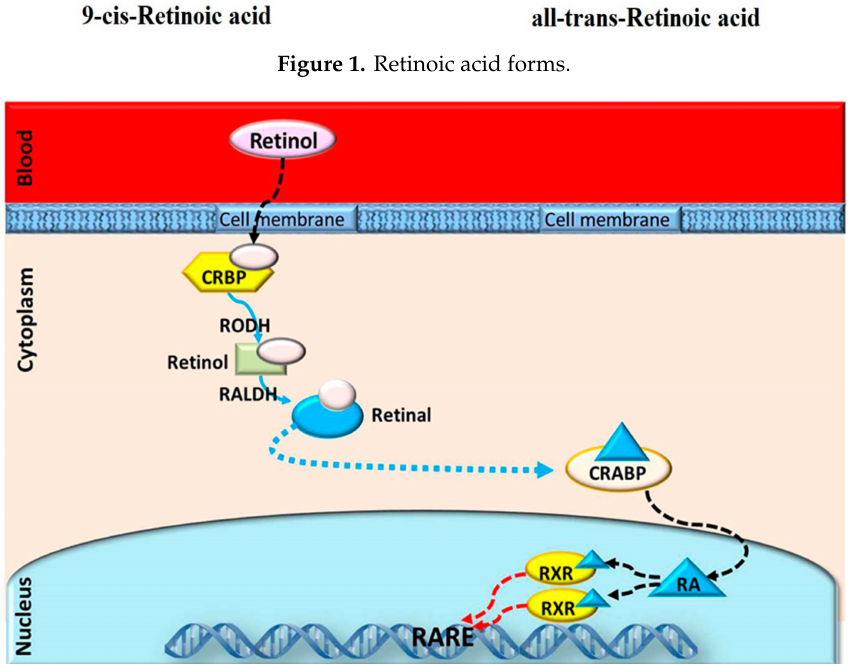
Figure 2. The cellular mechanism of retinoid action. Retinol is taken up from the blood and bound to CRBP (cellular retinol-binding protein) in the cytoplasm. The retinol dehydrogenase (RoDH) enzymes metabolize retinol to retinal, which is then metabolized to RA by the retinaldehyde dehydrogenases (RALDHs). RA is bound in the cytoplasm by cellular RA-binding protein (CRABP). RA enters the nucleus and binds to the RA receptors (RARs) and the retinoid X receptors (RXRs), which themselves heterodimerizeandbindtoasequenceofDNAknownastheRA-responseelement(RARE).Thisactivates the transcription of the target